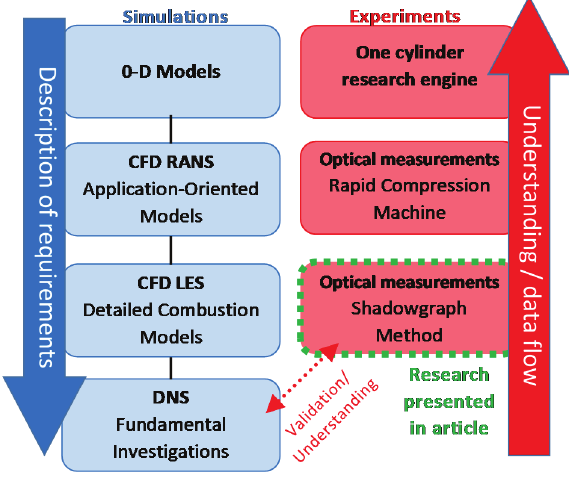
Fig. 3. Predicted tangent velocity field in the measurement plane; the “+” sign means the calculated vortex center (colors correspond to the velocity Fig. 5. Hierarchical research approach to the research topic using the of the mixture turbulence) [23] simulation research method and the experiment